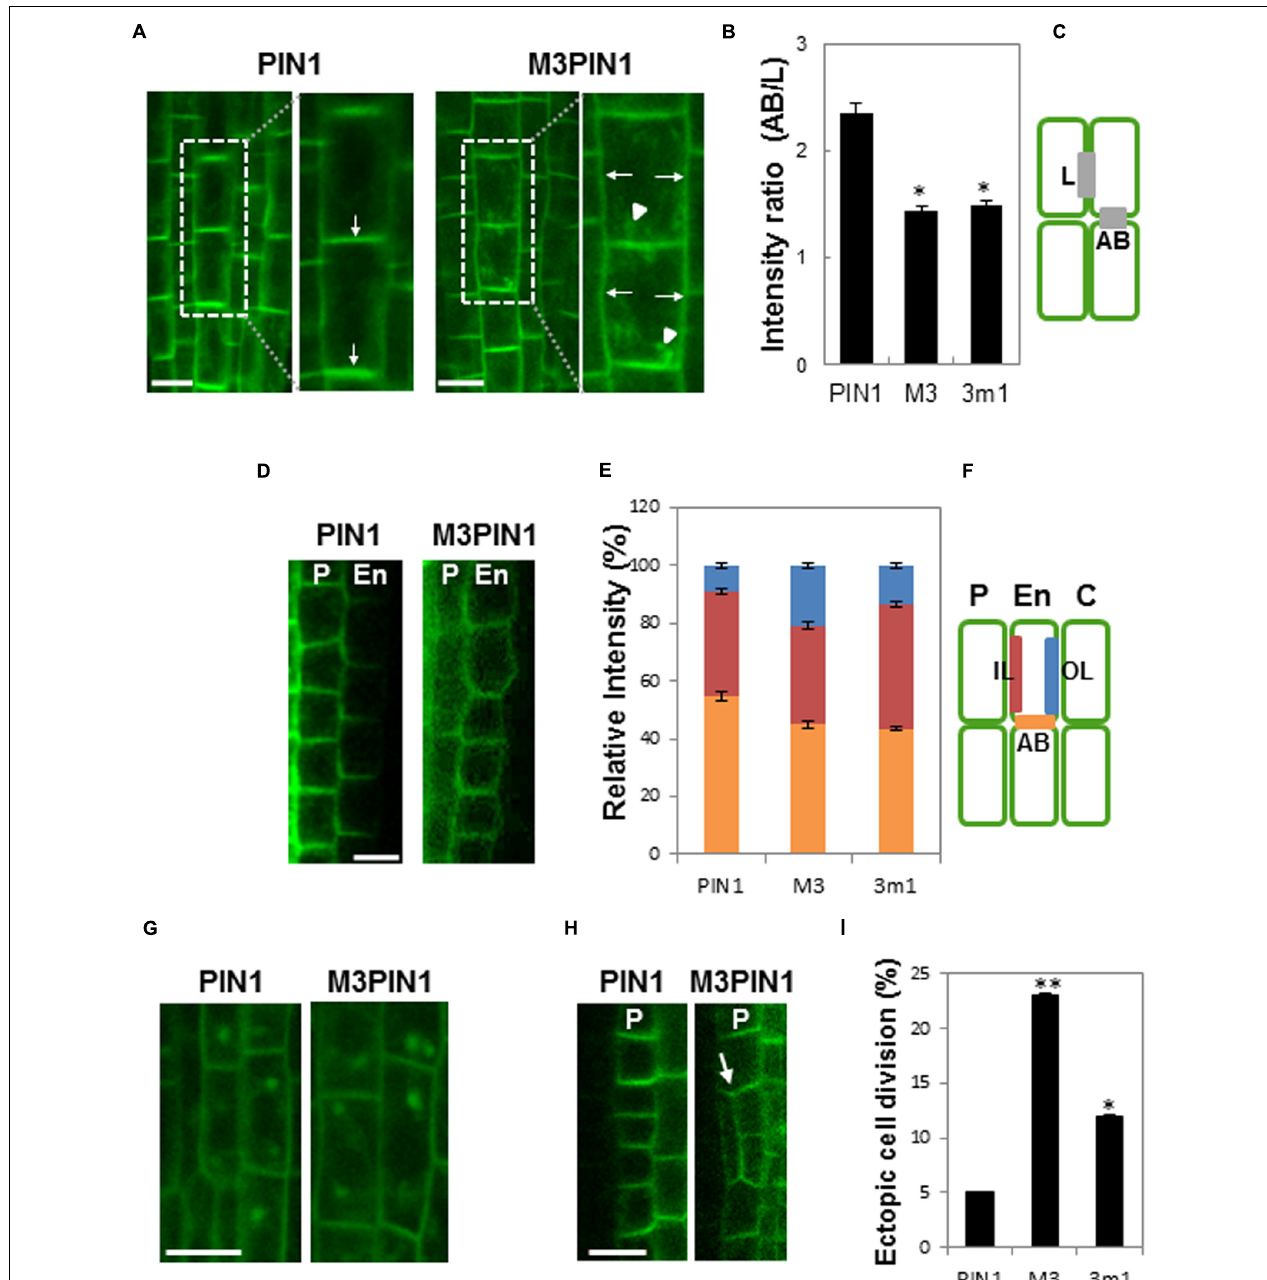
FIGURE 1 | Effects of M3 or 3m1 mutation on the polarity and trafficking of PIN1. (A) Representative confocal images of PIN1 ( ProPIN1:PIN1:GFP ) and M3PIN1 ( ProPIN1:M3PIN1:GFP ) in root vascular cells. Arrows indicate basally intensified and laterally depolarized localization of PIN1 and M3PIN1, respectively. Arrowheads indicate internalized compartments of M3PIN1. Bar = 10 µ m. (B,C) Quantification of the PIN polarity shown in (A) . The fluorescence ratio of apical and basal (AB)/lateral (L) membranes sides (gray bars in C ) of PIN1, M3PIN1, and 3m1PIN1 ( ProPIN1:3m1PIN1:GFP ). Data represent means ± SE ( n = 24–27 cells from 7 to 8 roots for each construct). Asterisks indicate that differences are significant from the PIN1 value ( P < 0.0001). (D) Representative confocal images showing the subcellular localization of PIN1 and M3PIN1 in pericycle (P) and endodermis (En) cells of the root. Bar = 10 µ m. (E,F) Quantification of the PIN polarity in the endodermis shown in (D) . The fluorescence ratio of outer lateral (OL in blue), inner lateral (IL in red), and apical and basal (AB in orange) membrane as shown in (C) was estimated with wild-type (WT) and mutant PIN1 lines (C, cortex). Data represent means ± SE ( n = 25 cells from 8 to 9 roots for each construct). (G) Representative confocal images showing BFA compartments of PIN1- and M3PIN1 in root vasculature cells. Bar = 10 µ m. (H) Representative confocal images of ectopic cell division in the WT or mutant PIN1-expressing root pericycle (P). Arrow indicates ectopic cell division region. Bar = 10 µ m. (I) Ratio of seedlings showing ectopic cell division in pericycle and endodermis cells ( n = 18 seedlings each). Data are significantly different from the PIN1 value at ∗ P < 0.05 and ∗∗ P < 0.0001 in t -test.